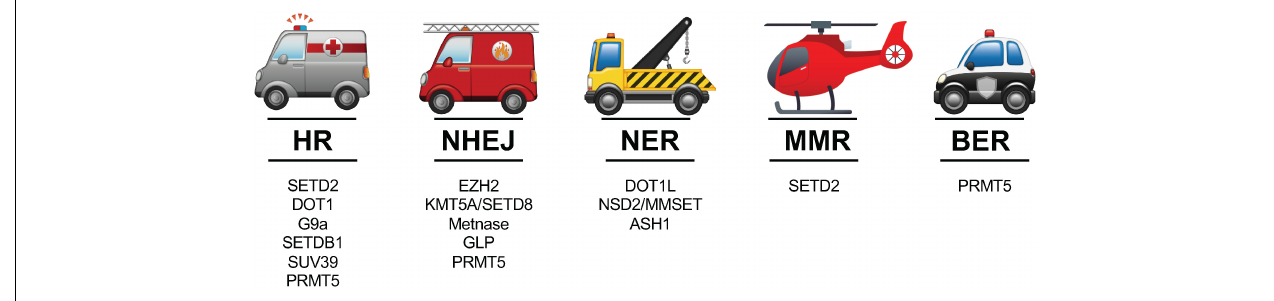
FIGURE 1 | The 5 major DDR pathways and prominent HMTs involved in the context of those distinct pathways. See text for references of studies highlighting the various roles of HMTs in these